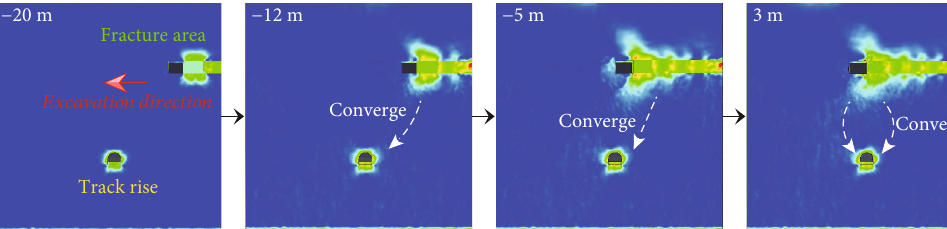
Figure 3: Variation pattern of fracture zone with the advance of working face.